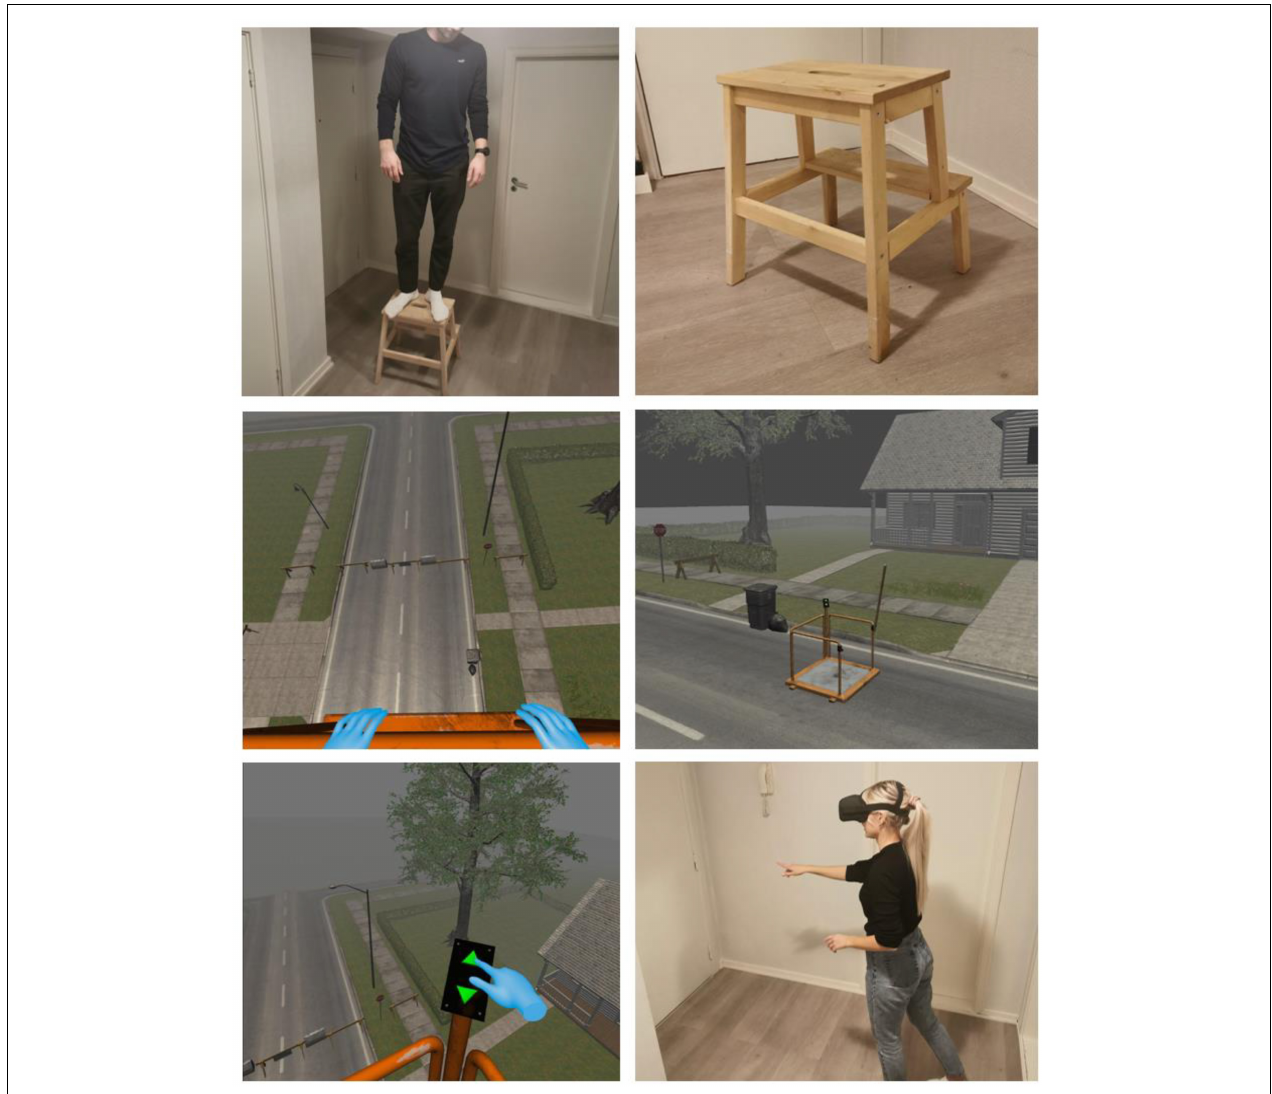
FIGURE 1 | Inner and outer perspectives of the